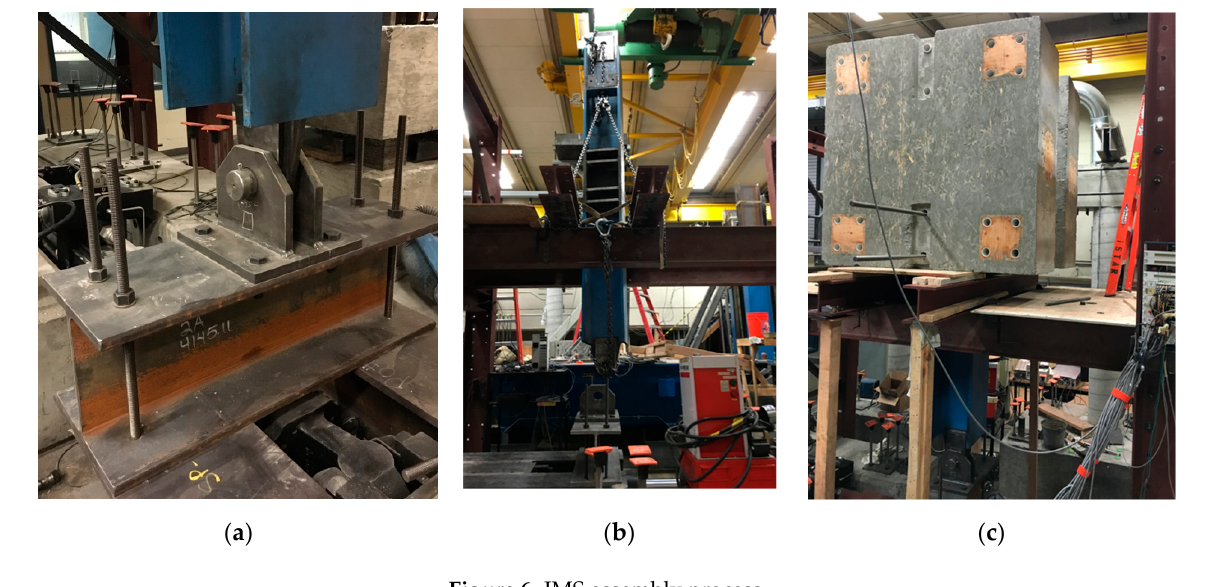
Figure 6. IMS assembly process.